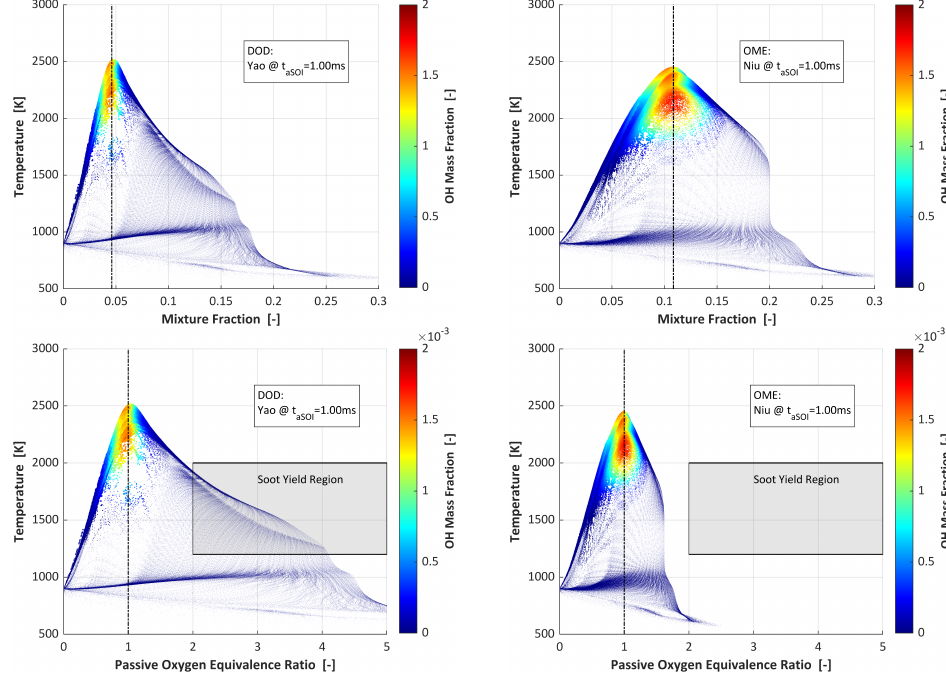
Figure 17. Conti3L ( Ar ): Simulation temperature in mixture fraction space ( top ) and passive scalar oxygen equivalence ratio space ( bottom ). ( left ) Dodecane. ( right )